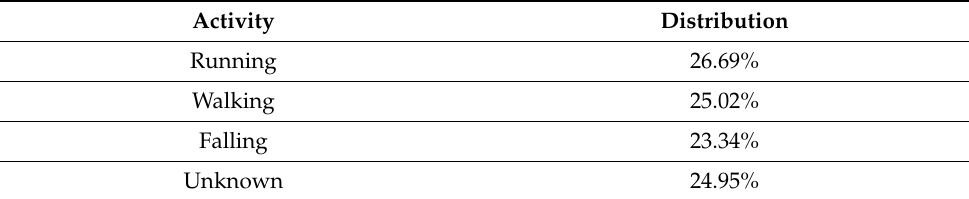
Table 3. Distribution of activities in the recorded dataset.